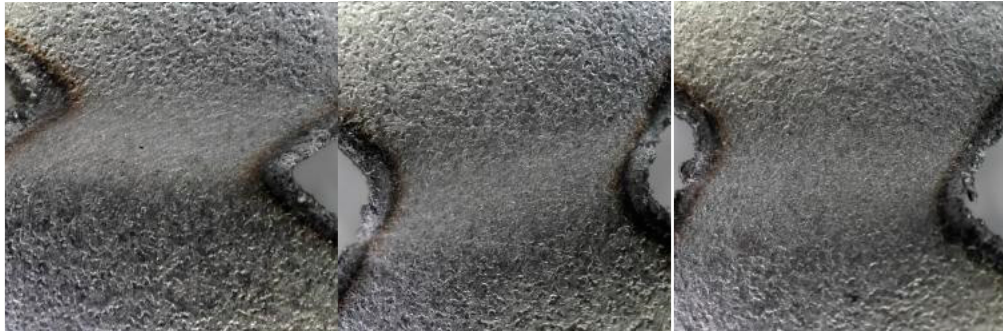
Figure 17. Test diagram before fracture of 0°, 30°, and 60° specimens.